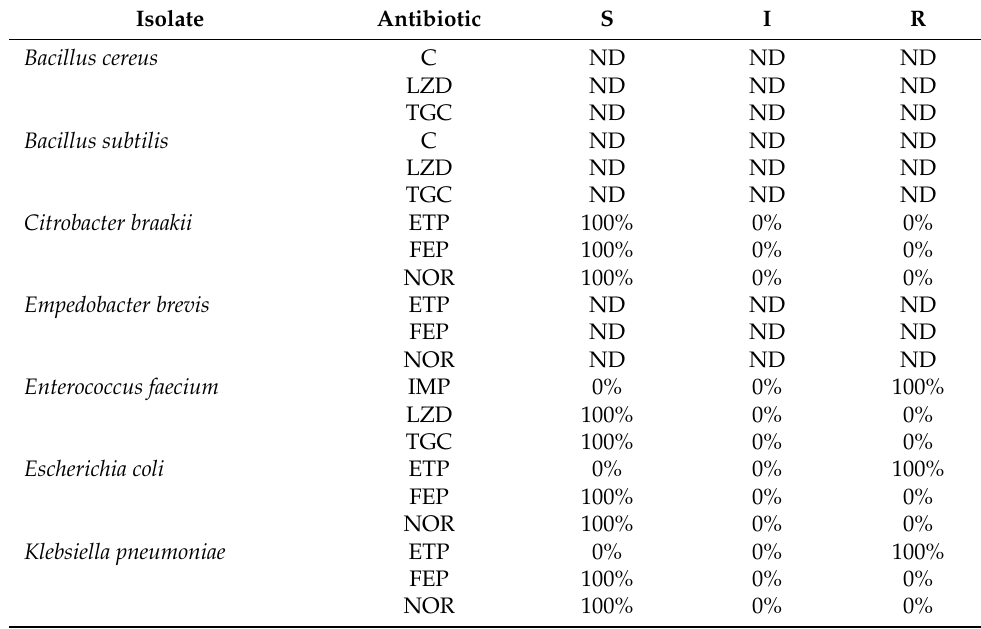
Table 1. Resistance profiles of bacteria found in turkey semen .